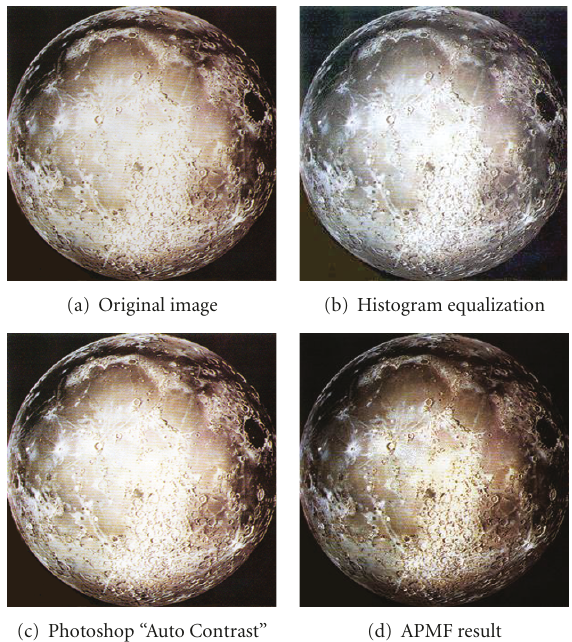
Figure 8: Comparison of di ff erent contrast enhancement